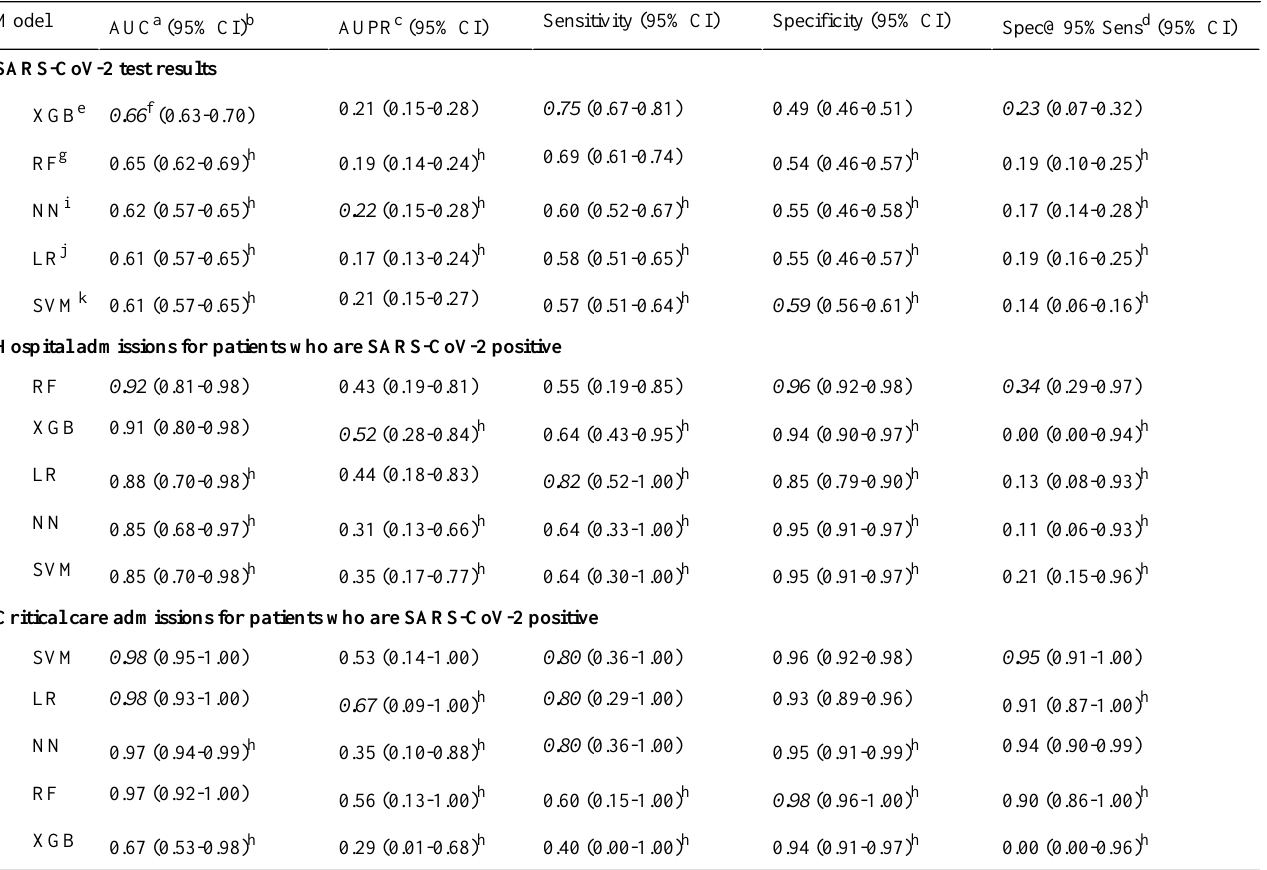
Table 3. Comparison of LR, NN, RF, SVM, and XGB models in terms of AUC, AUPR, sensitivity, specificity, and Spec@95%Sens for predicting SARS-CoV-2 test results, hospital admission for patients who are SARS-CoV-2 positive, and intensive care unit admission for patients who are SARS-CoV-2 positive on the test set